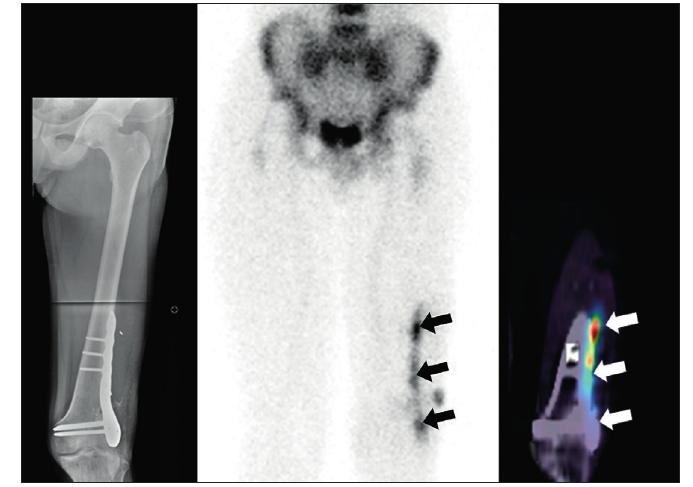
Fig. 4. A longitudinal ultrasound section demonstrating a periosteum of a tibial shaft displaced by inflammatory collection in a young patient with clinical signs of infection.